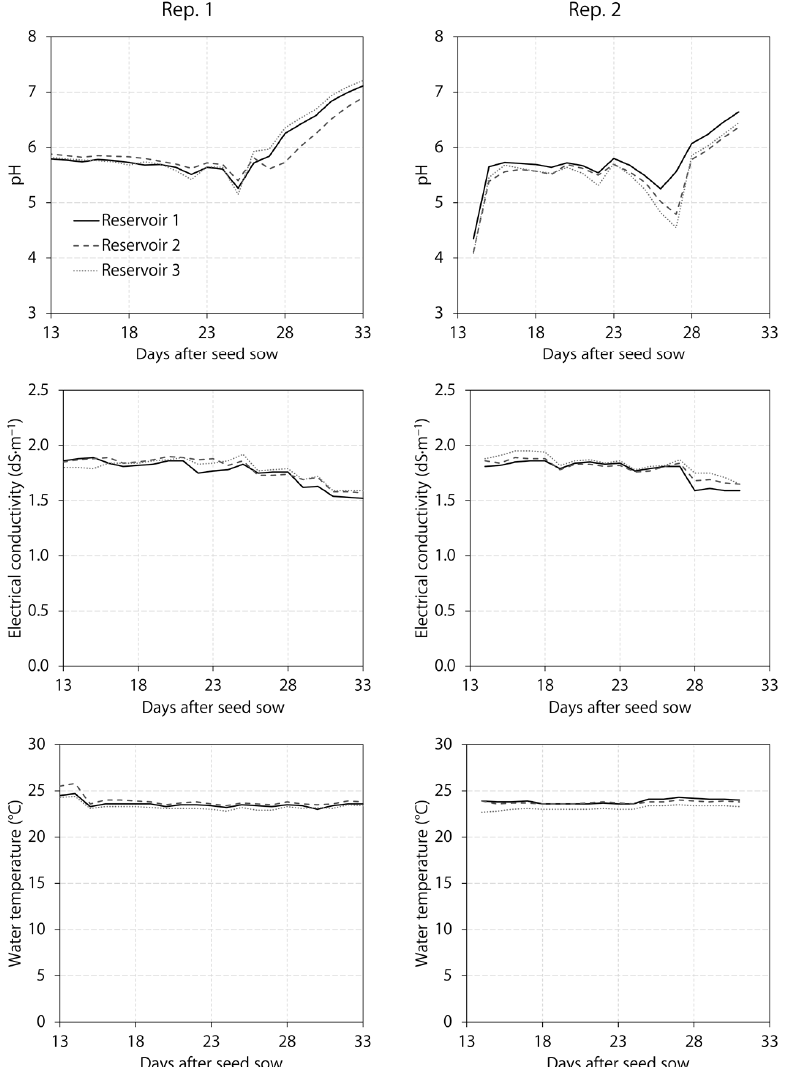
Figure 5. Nutrient solution pH, electrical conductivity, and temperature of three reservoirs used throughout two experimental replications (Rep.) for six indoor lighting treatments delivered by warm-white, mint-white, blue, green, and/or red light-emitting diodes (LEDs). Reservoir 1 was for the two blue + green + red LED treatments. Reservoir 2 was for the mint-white LED treatment. Reservoir 3 was for the warm-white LED treatment and the two mint-white + blue + red LED treatments. A ventilation and air-conditioning unit (HBH030A3C20CRS; Heat Controller, LLC., Jackson, MI, USA), which was connected to a wireless thermostat controller (Honeywell International, Inc., Morris Plains, NJ, USA), maintained a constant air temperature set- point of 22 °C. Plants were grown at the ambient CO 2 concentration. We monitored the environment with a temperature and relative humidity sensor (HMP110; Vaisala, Inc., Louisville, CO, USA) and a CO 2 sensor (GMD20; Vaisala, Inc.). Sensors were wired to a datalogger (CR1000; Campbell Scientific, Inc., Logan, UT, USA) that recorded hourly means of 10 s intervals (Figure 6). The mean air temperature, CO 2 concentration, and rel- ative humidity (mean ± SD ) were 22.4 ± 0.6 °C, 410 ± 50 μ mol·mol − 1 , and 34% ± 10%, re- spectively, in replication 1 and 22.5 ± 0.6 °C, 398 ± 35 μ mol·mol − 1 , and 35% ± 7%, respec- tively, in replication 2.